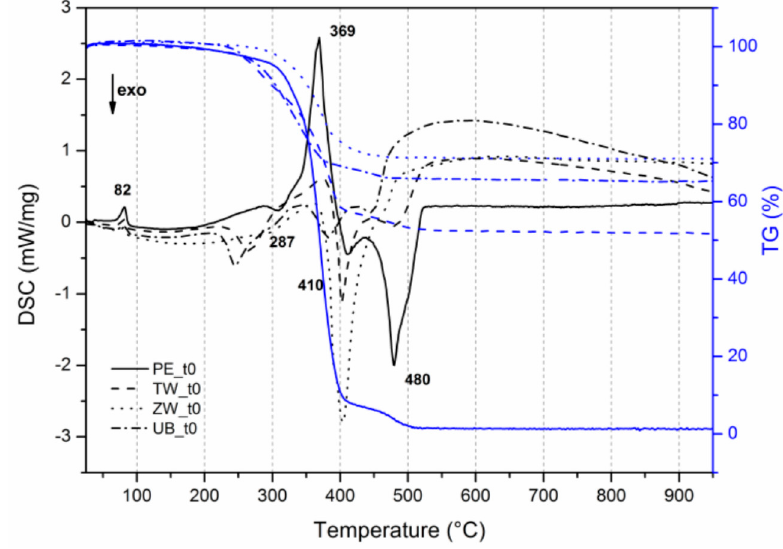
Figure 10. TG-DSC profiles of unpigmented and pigmented mock-ups at t0.